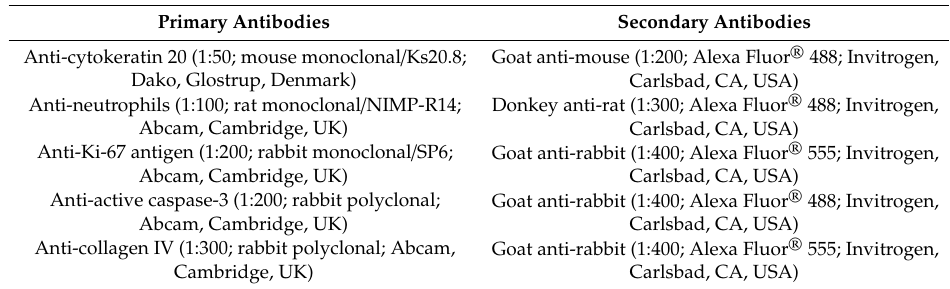
Table 3. Primary and secondary antibodies used for immunohistochemistry on cryosections. Primary Antibodies Secondary Antibodies Anti-cytokeratin 20 (1:50; mouse monoclonal / Ks20.8; Goat anti-mouse (1:200; Alexa Fluor ® 488; Invitrogen, Dako, Glostrup, Denmark) Carlsbad, CA, USA) Anti-neutrophils (1:100; rat monoclonal / NIMP-R14; Donkey anti-rat (1:300; Alexa Fluor ® 488; Invitrogen, Abcam, Cambridge, UK) Carlsbad, CA, USA) Anti-Ki-67 antigen (1:200; rabbit monoclonal / SP6; Goat anti-rabbit (1:400; Alexa Fluor ® 555; Invitrogen, Abcam, Cambridge, UK) Carlsbad, CA, USA) Anti-active caspase-3 (1:200; rabbit polyclonal; Goat anti-rabbit (1:400; Alexa Fluor ® 488; Invitrogen, Abcam, Cambridge, UK) Carlsbad, CA, USA) Anti-collagen IV (1:300; rabbit polyclonal; Abcam, Goat anti-rabbit (1:400; Alexa Fluor ® 555; Invitrogen, Cambridge, UK) Carlsbad, CA,